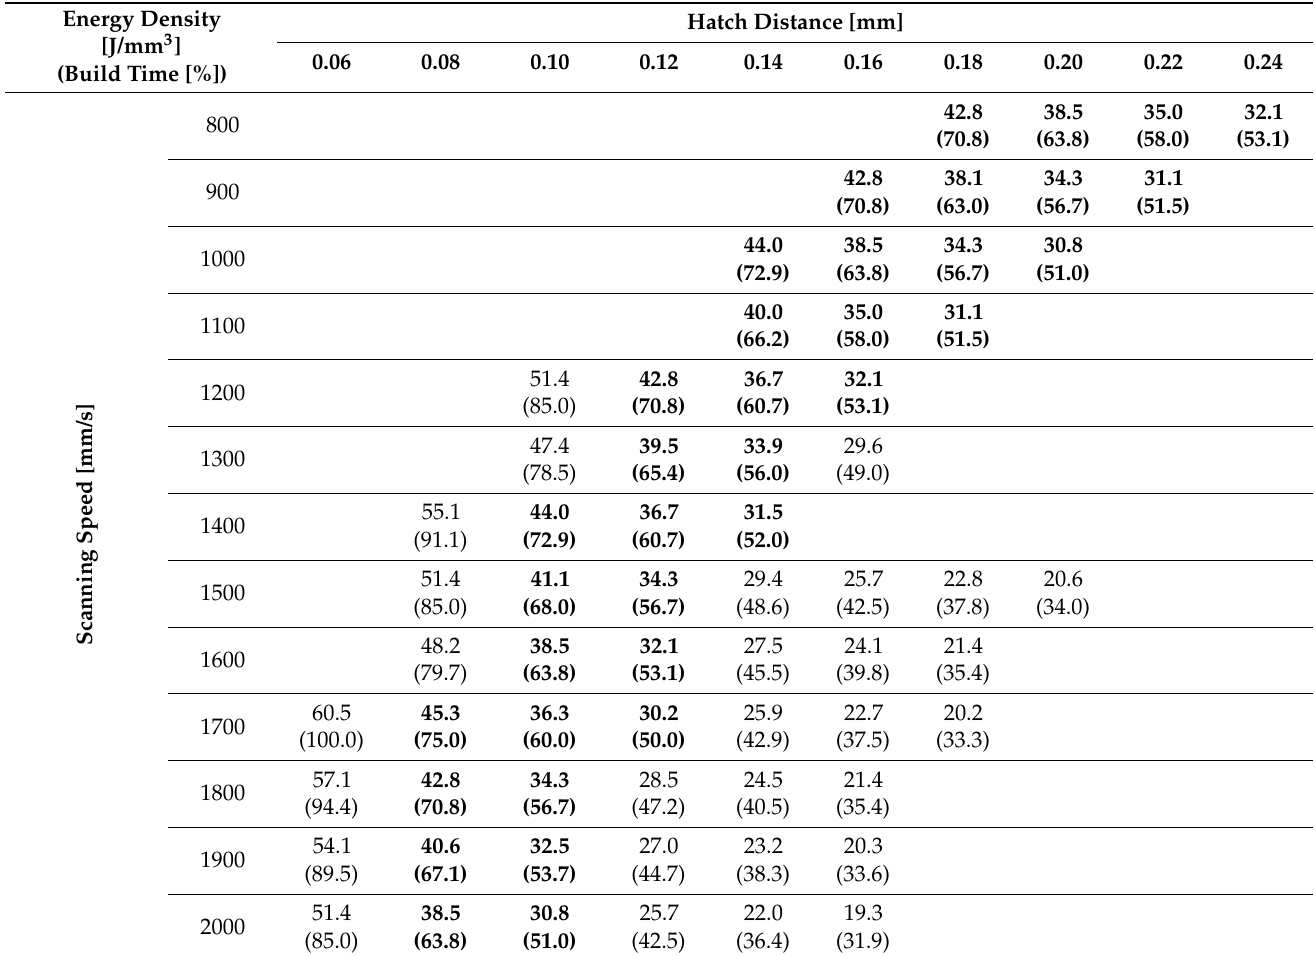
Table 2. Tested combinations of hatch distance and scanning speed. Each cell reports the corre- sponding energy density and, in parentheses, the percent build time, with the most time-consuming parameter set ( v = 1700 mm/s, h = 0.06 mm) as a reference. The bold and non-bold values correspond to the parameters analyzed in the first and second experimental steps,